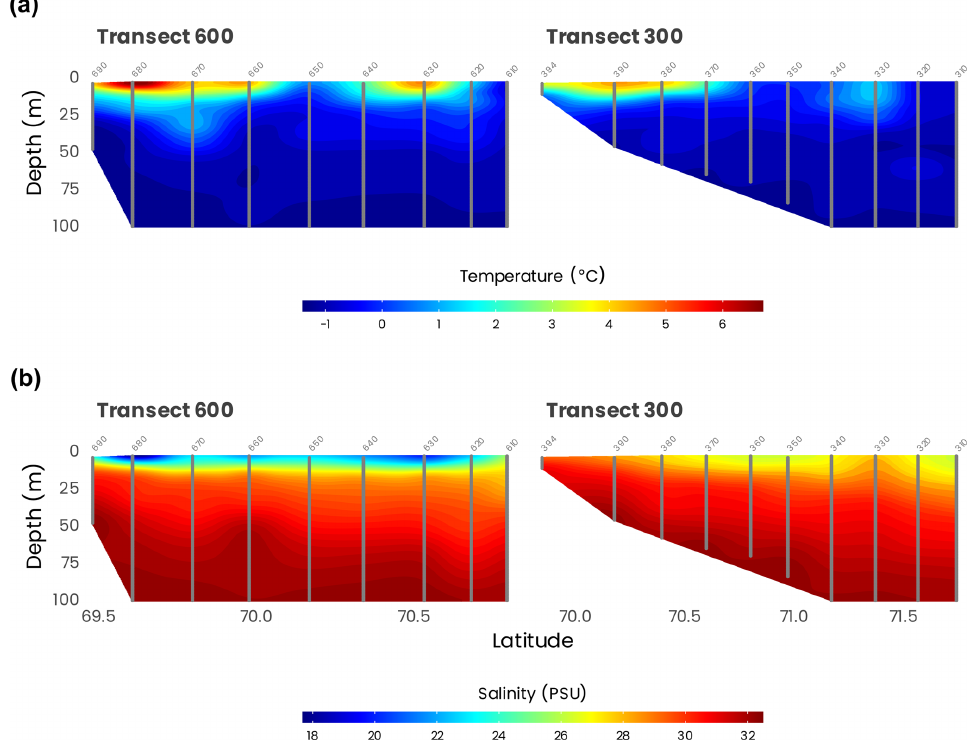
Figure 5. Cross-sections of temperature (a) and salinity (b) measured by the CTD (gray dots) along transects 600 and 300. Station numbers are identified in light gray on top of each